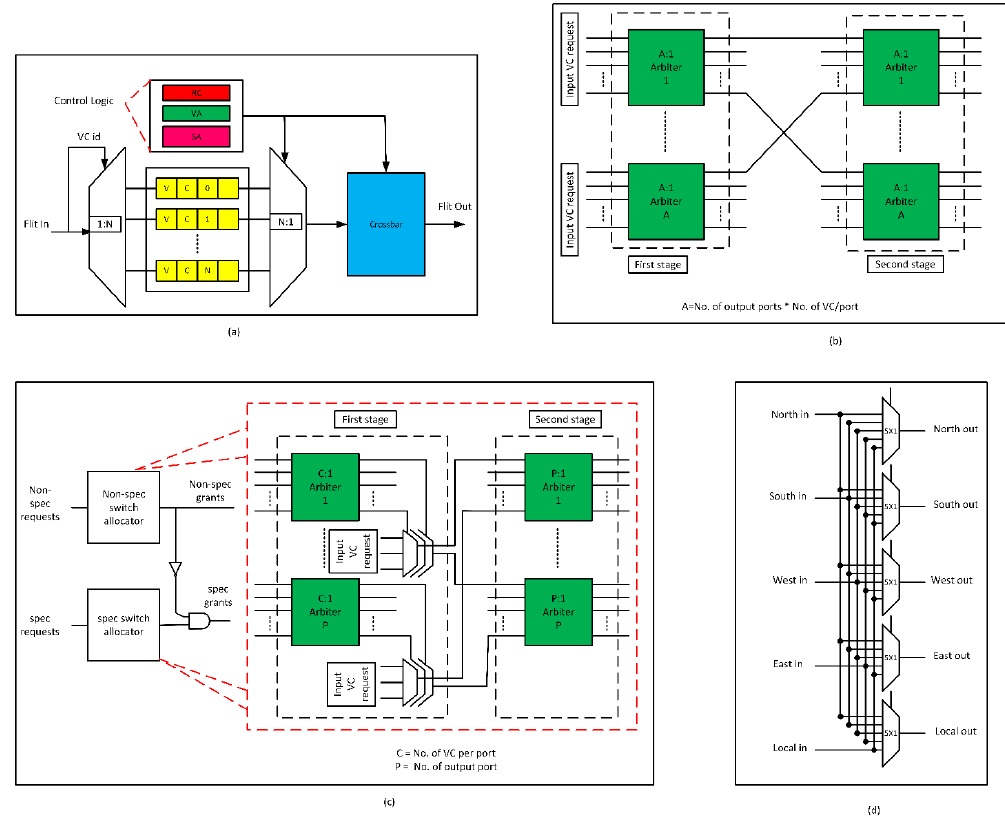
Figure 2. Pipeline stages in router architecture: ( a ) input port, ( b ) virtual channel (VC) allocator, ( c ) switch allocator, ( d )